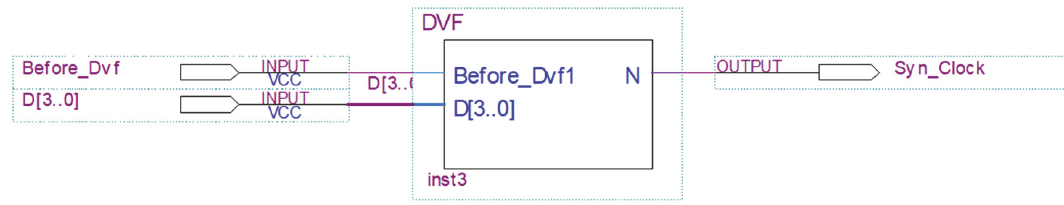
Figure 11: Schematic of numerically controlled frequency divider circuit.